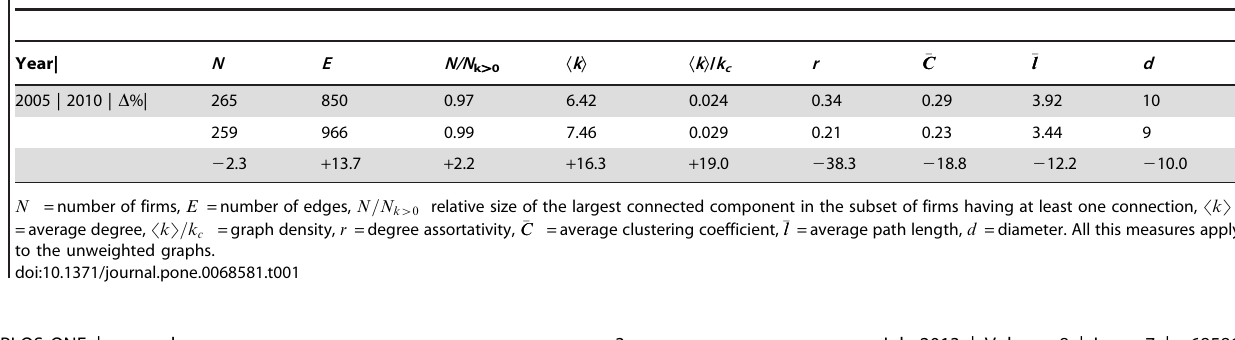
Table 1. Basic statistics of the largest connected components of boards